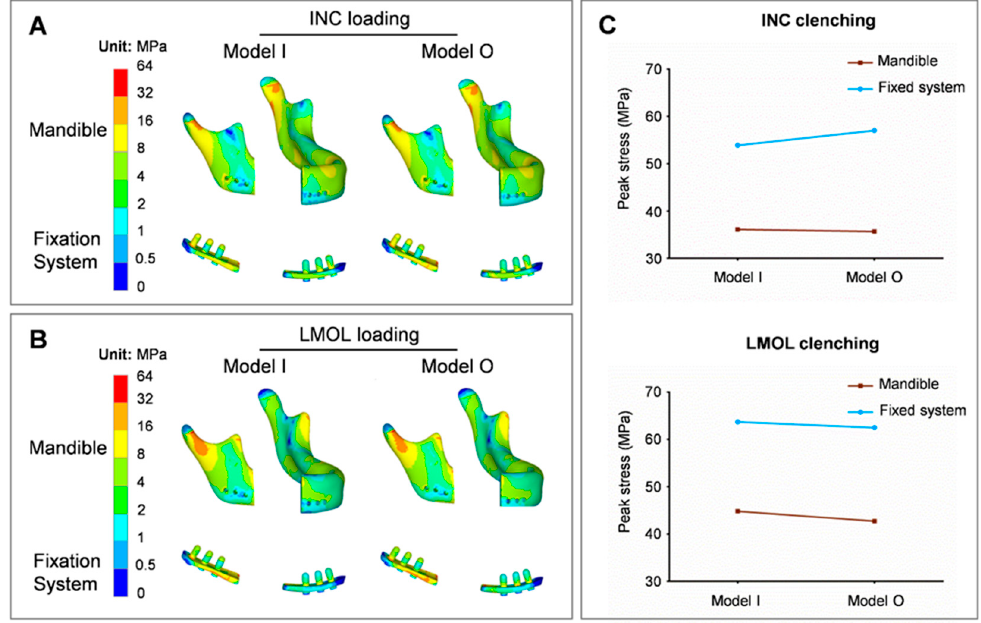
Figure 7. Von Mises stress distribution for mandible and fixation system subjected to INC loading ( A ) and LMOL loading ( B ), and the line chart for their maximum stress values ( C ). Figure 8A shows the geometric features of the prosthesis. The prosthetic strut diam- eters are marked in eight colors, in which warmer and colder colors indicate larger and